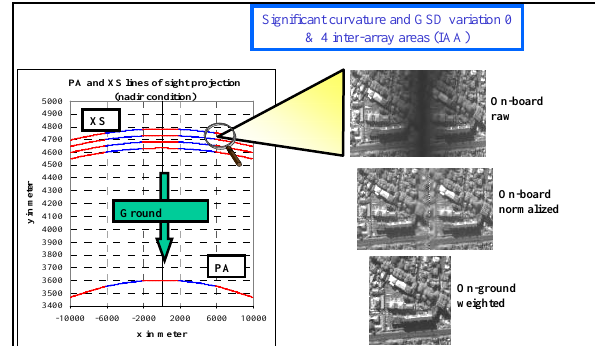
Figure 2: Focal plane and image reconstruction